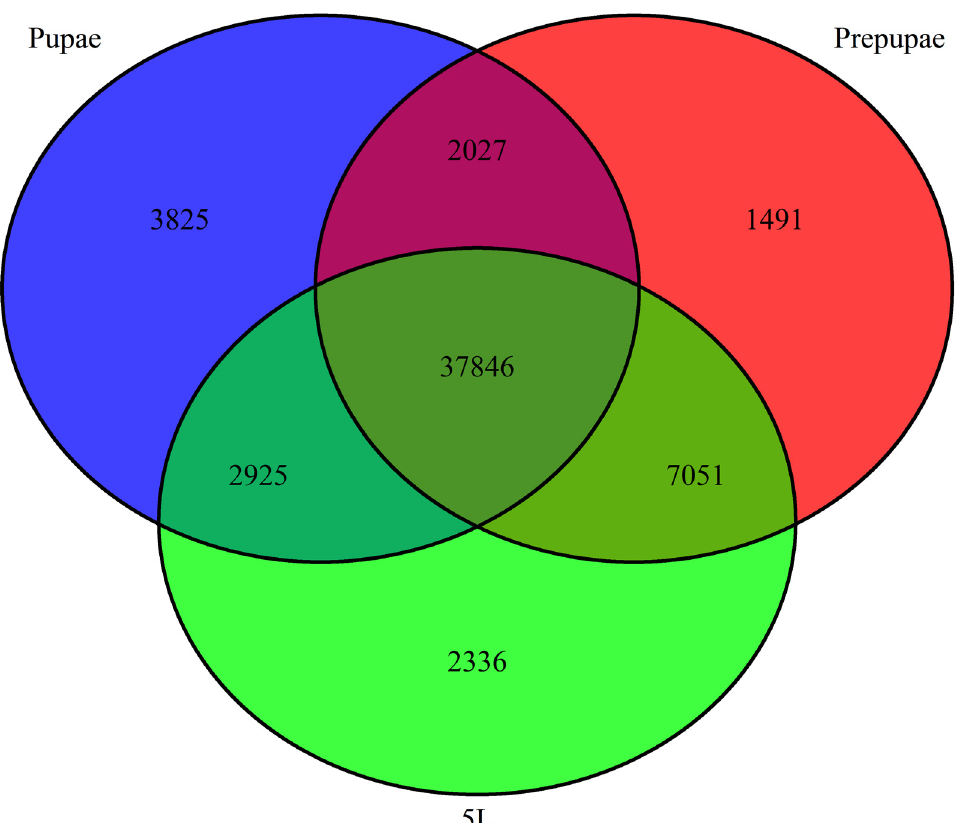
Fig 2. A Venn diagram showing overlap of silk gland genes expressed in larval, prepupal and pupal stages. 5L represents fifth instar larvae.